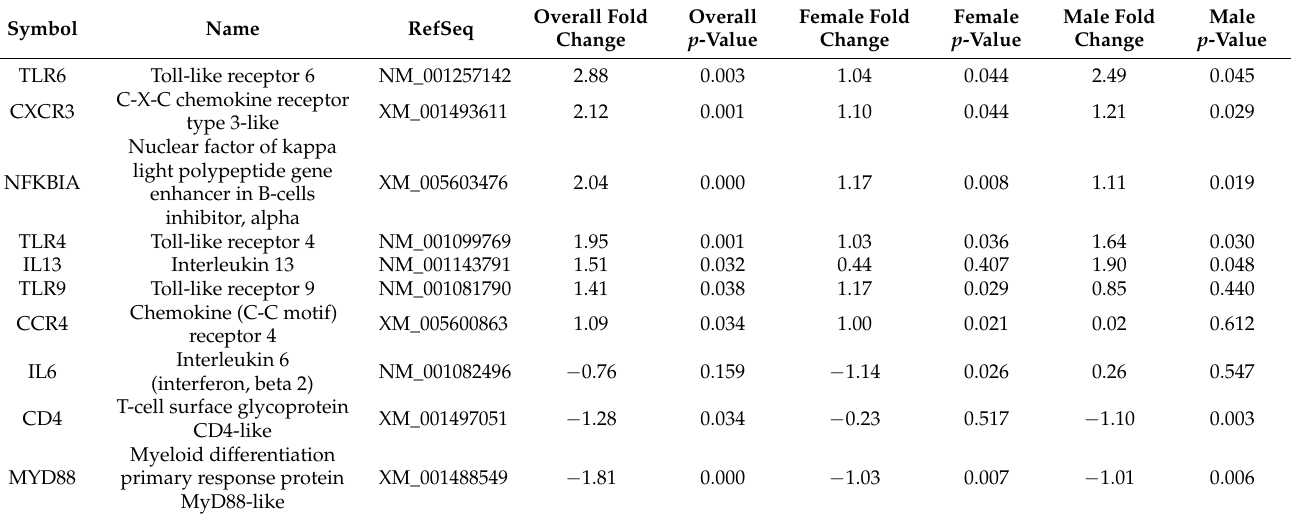
Figure 2. Transcriptional changes of the 84 innate and adaptative immune genes in horses. The horizontal line (dashed) indicates a p -value threshold of 0.05. Genes with data points in the upper left (downregulated and red) and upper right (upregulated and green) sections showed greater than the 1-fold regulation and p -value thresholds. Genes with identical expression patterns grouped around the 0 fold change and p -value. Table 1. Differentially expressed mRNAs of the innate and adaptative immune genes in horses before and after a high intensity training session. Basal expression (before competition) was set to 0 and the expression fold difference was calculated from that level up or down. The overall analysis changes were calculated using all of the individuals regardless of sex. Changes were calculated for each sex